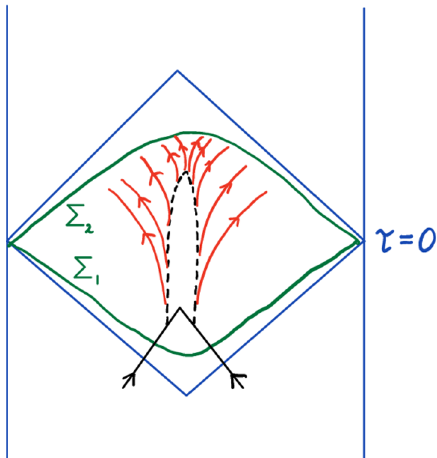
Figure 3 . Shown is a “Wheeler-DeWitt” patch associated with a given boundary time. Since evolution between the slices Σ 1 and Σ 2 occurs at fixed boundary time, it should be generated by the constraints. This evolution could include non-perturbative processes, such as black hole formation and